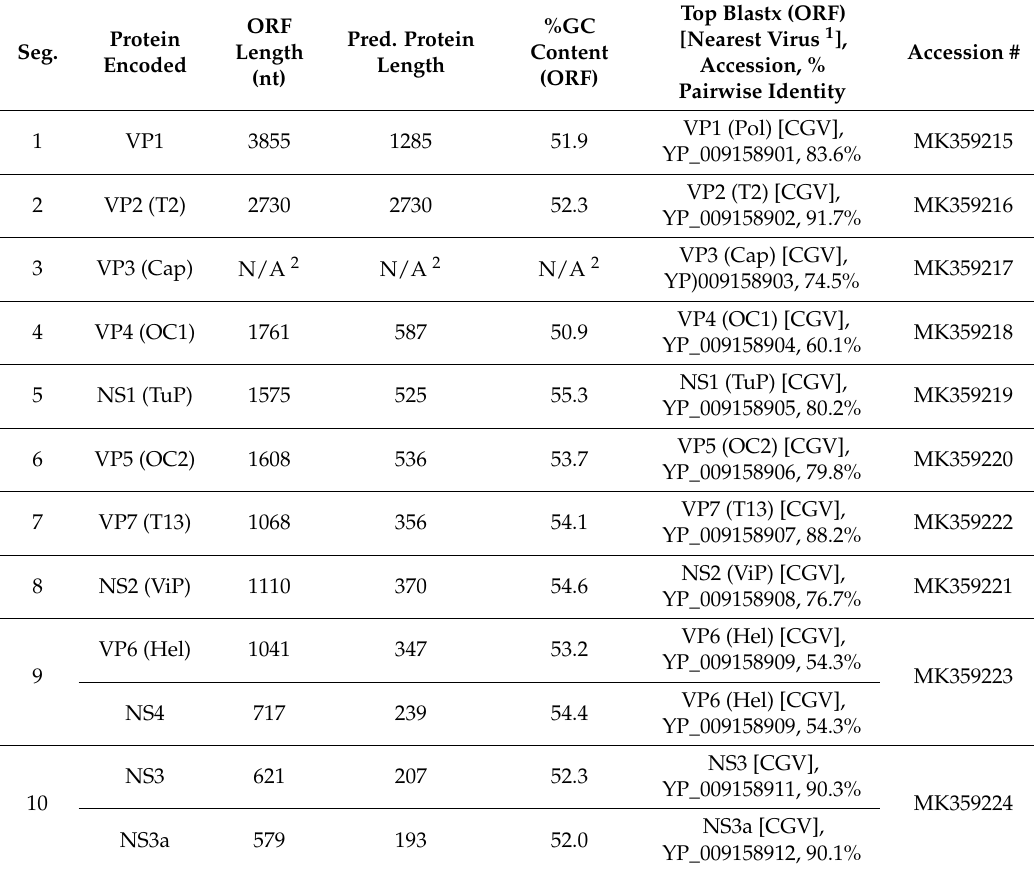
Table 2. Genetic analysis of BUKV genome segments, predicted ORFs, and predicted proteins.